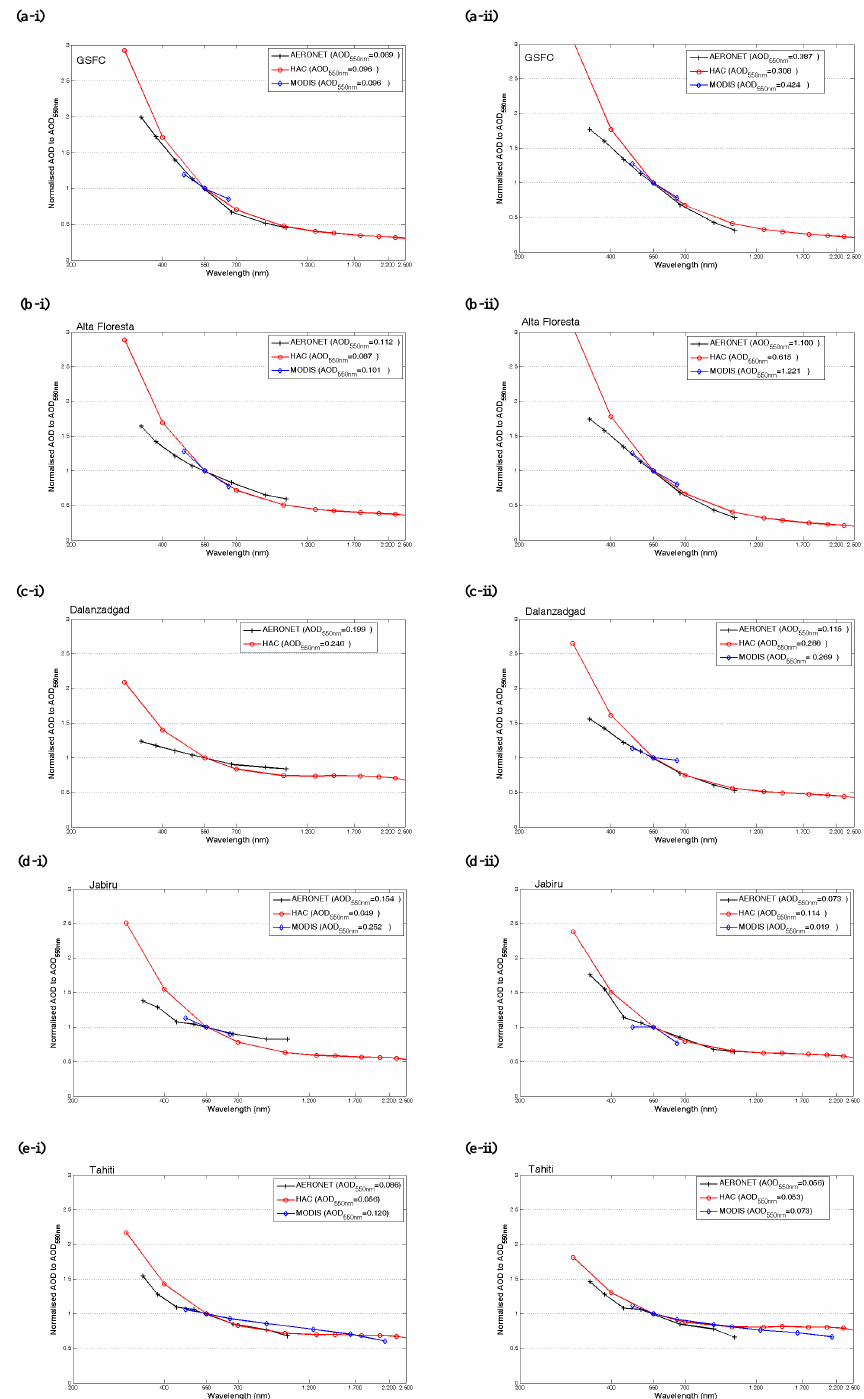
Figure 6. Spectral profile of Aerosol Optical Depth (AOD) and the differences between the three datasets over the five selected sites (see Fig. 5) for January (left column, all sites except Dalanzadgad where April is shown) and July (right, all sites except Alta Floresta, where September is shown). Symbols and lines are: solid black lines with plus signs for AERONET data, solid red lines with circles for HAC data, solid blue lines with diamonds for MODIS. The values on y-axes are AOD values normalised to the AOD value at 550 nm. The legend boxes mention AOD for each dataset at 550 nm.